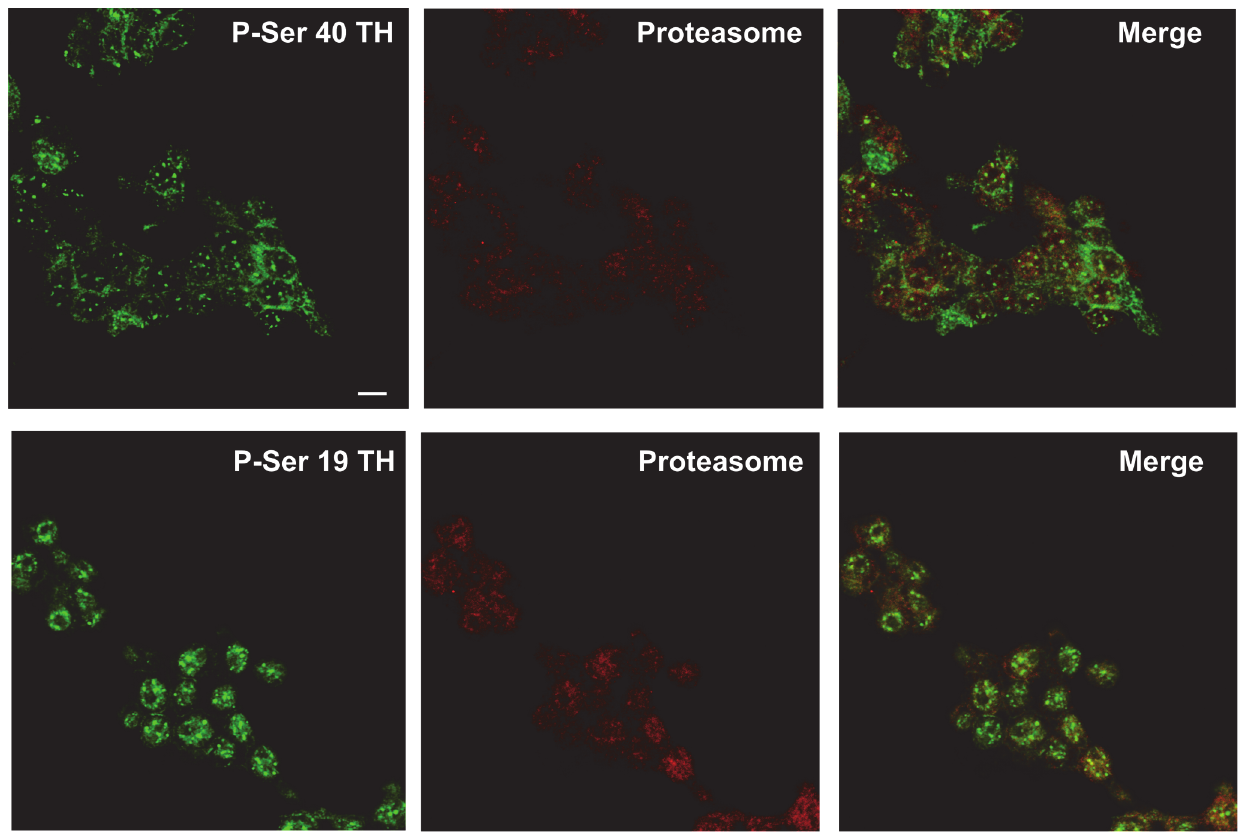
Fig 5. Colocalization of phospho-Ser40-TH (P-Ser 40 TH) or phospho-Ser19-TH (P-Ser 19 TH) with proteasome in PC12 cells. Cells were incubated with either rabbit phospho-Ser40-TH plus mouse proteasome antibodies (upper panel) or rabbit phospho-Ser19-TH plus mouse proteasome antibodies (lower panel) followed by incubation with an anti-rabbit antibody coupled to Alexa 488 and anti-mouse coupled to AlexaFluor 594. See text for details. Scale bar = 5 μ m. Three separate cell culture preparations were performed and 10 different images were taken and analyzed for each experiment. One representative image is